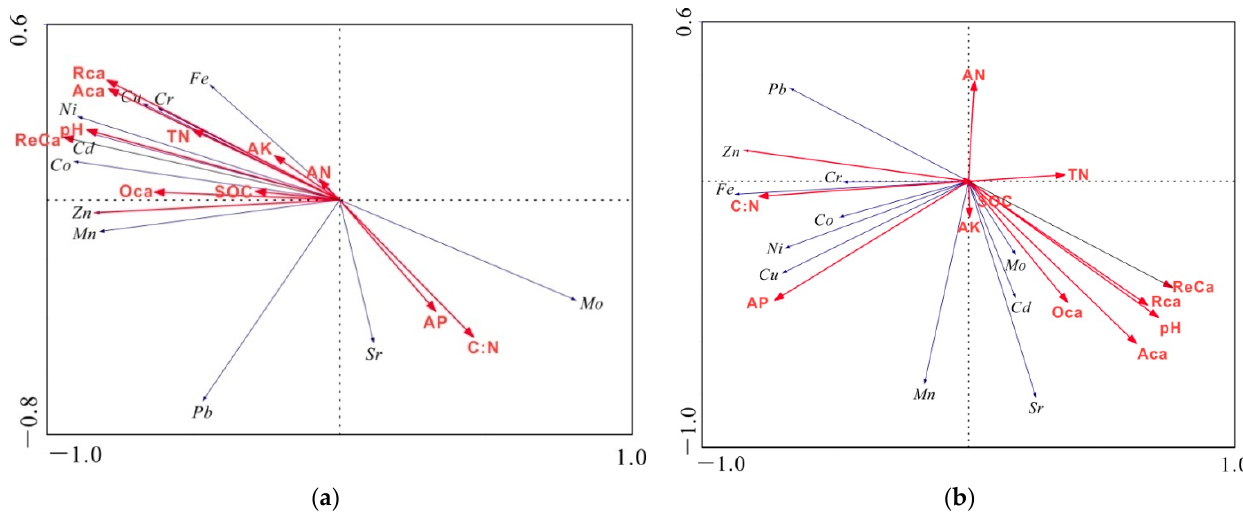
Figure 3. Two-dimensional RDA ordination diagrams of soil environmental factors and C T ( a ) and C A ( b ) of heavy metals.